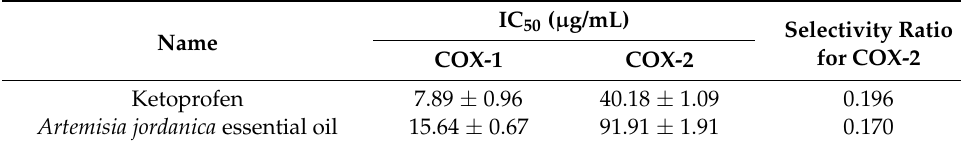
Figure 7. The inhibition percentage of Artemisia jordanica essential oil against COX1 and COX2 at two different concentrations 50 and 350 µg/mL ± SD. Table 4. IC 50 values of COX-1 and COX-2 and COX-2 inhibition selectivity of Artemisia jordanica essential oil.